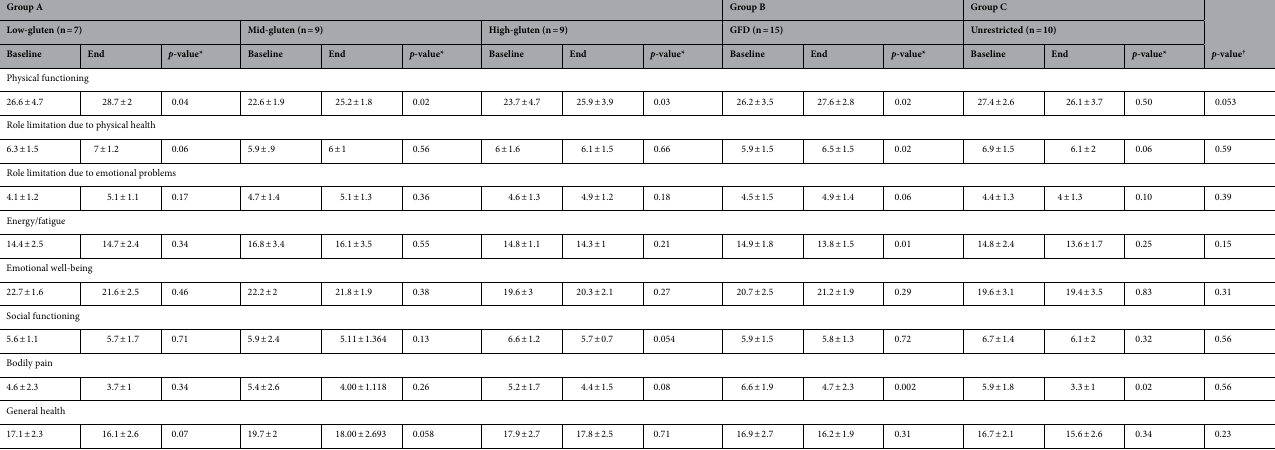
Table 4. Mean ± SD scores for Short Form-36 (SF-36) Health Survey scales within groups and between groups at the end of the study (Mann–Whitney U test was used for testing each two groups. No significant differences were observed between each two groups). * p -value for comparison within each group using the Wilcoxon- signed rank test. † p -value for between-groups comparison using the Kruskal–Wallis test. Higher scores in the SF-36 indicate better health. Differences across groups A, B and C were analyzed with a linear mixed model and p- values are given for the main effect of gluten challenge. SD standard